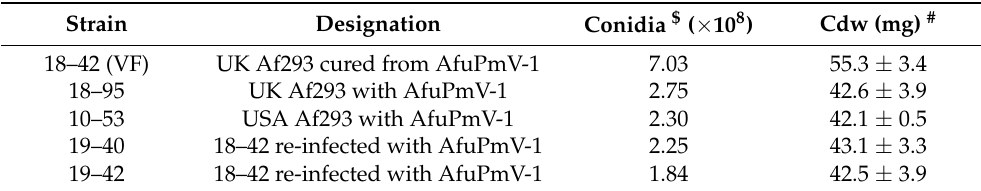
Table 1. The growth characteristics of VF and VI A. fumigatus strains (see text for details). $ Number of conidia harvested from solid medium. # Pellet cell dry weight (cdw) obtained from the liquid medium ( n =